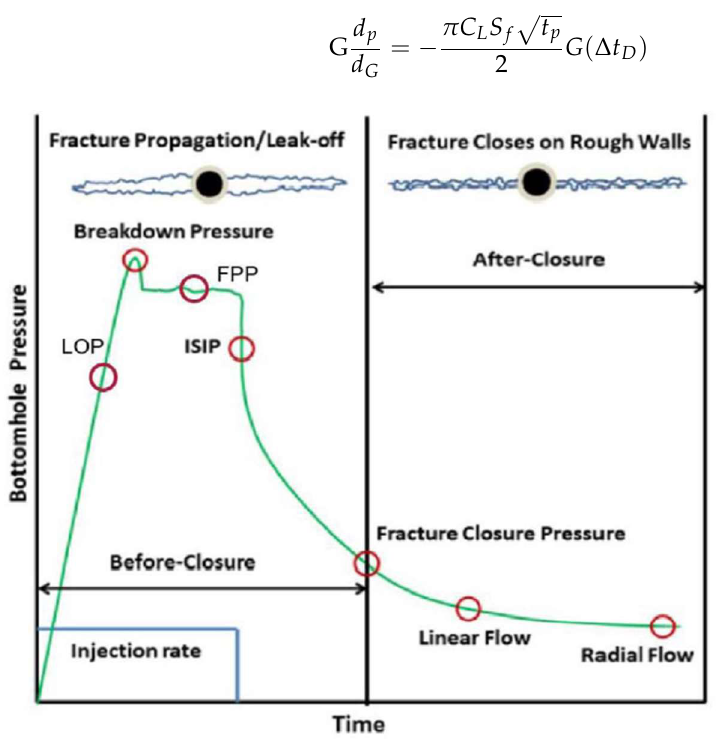
Figure 1. Typical DFIT data and relevant physical phenomena in region of Before Closure and region of After Closure.